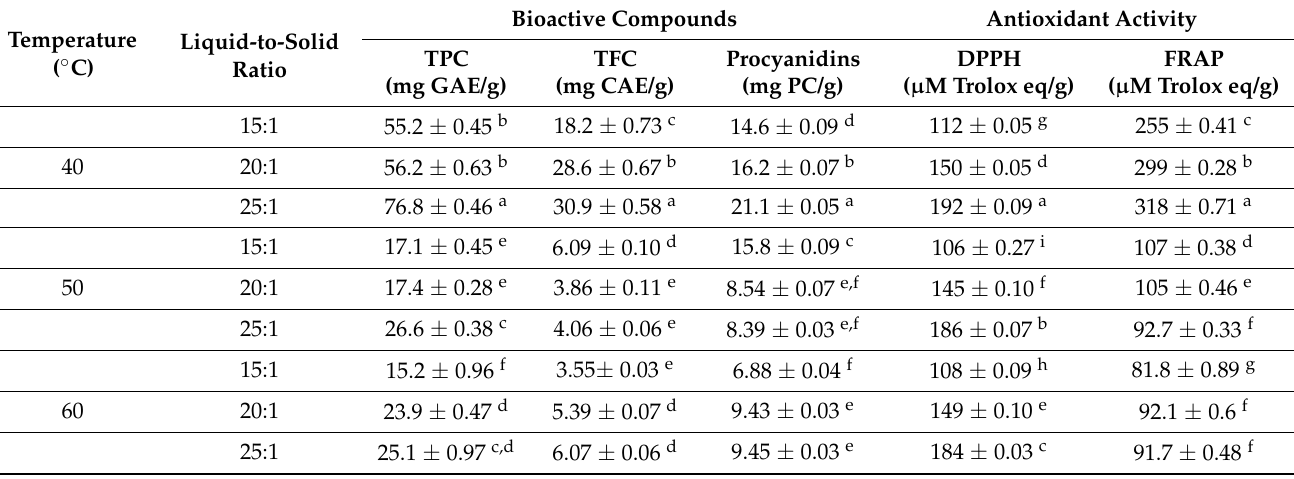
Table 1. Effects of liquid-to-solid ratio and extraction temperature on bioactive compounds and antioxidant capacity of GSS